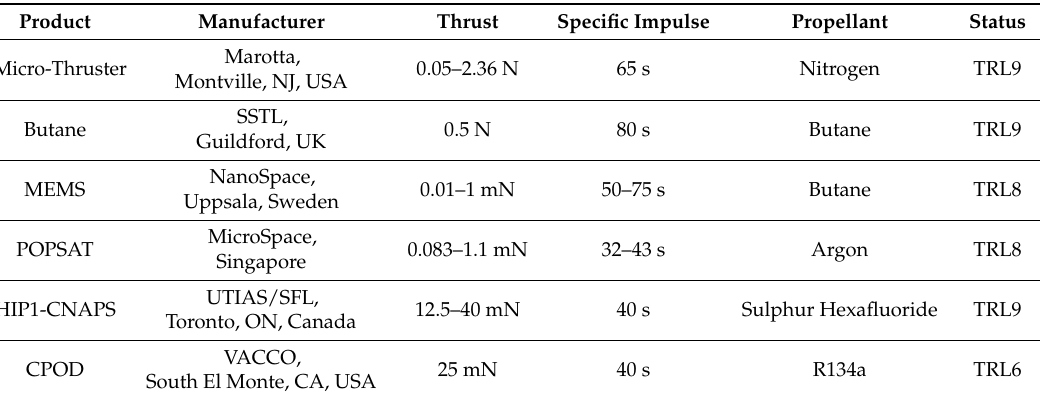
Table 7. Cold and Warm Gas Propulsion Systems [23].